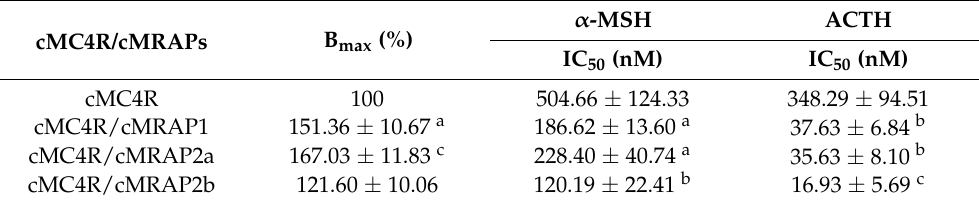
Table 5. The effect of MRAPs on ligand binding properties of cMC4R.